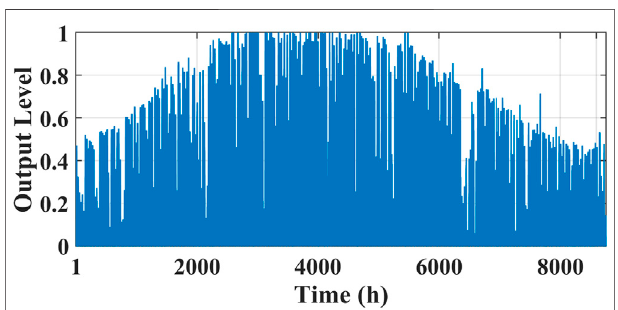
FIGURE 6 | PV annual curve.